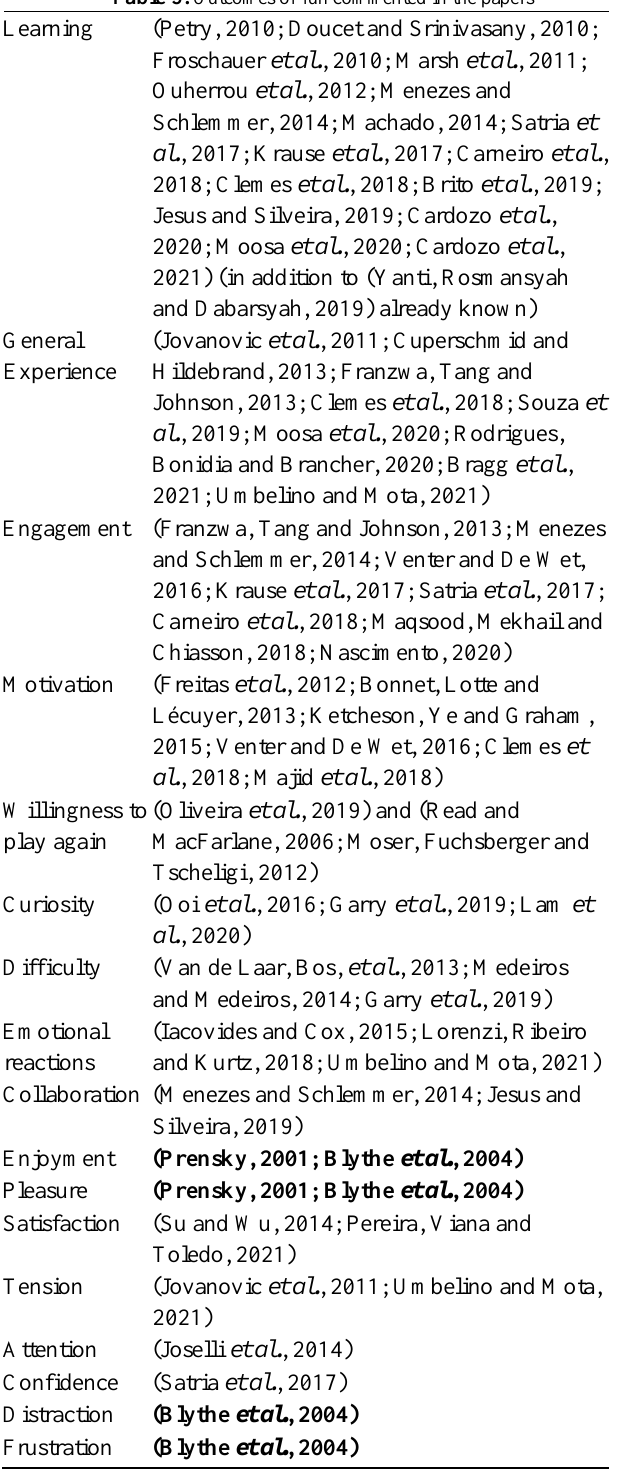
Table 5. Outcomes of fun commented in the papers Learning